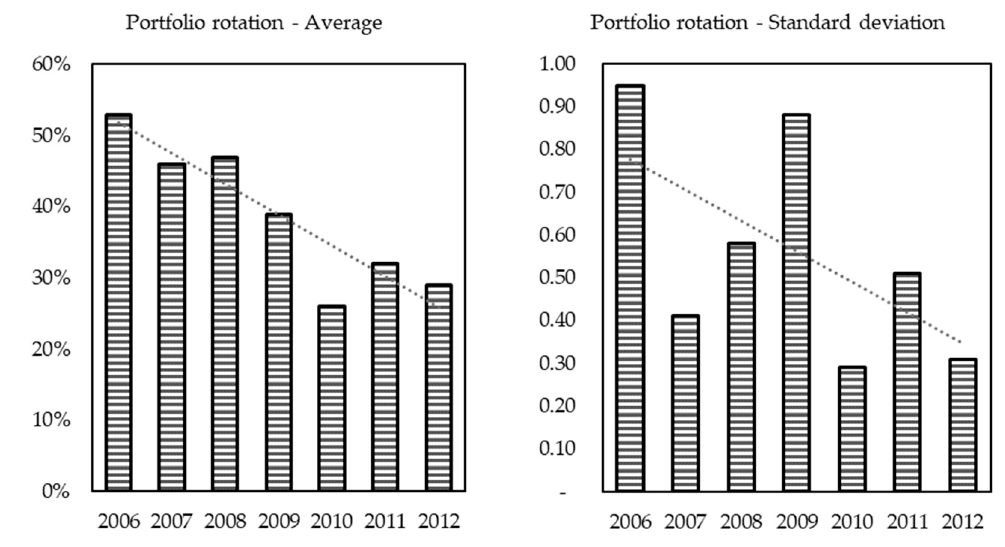
Figure 2. Galleries’ portfolio rotation.